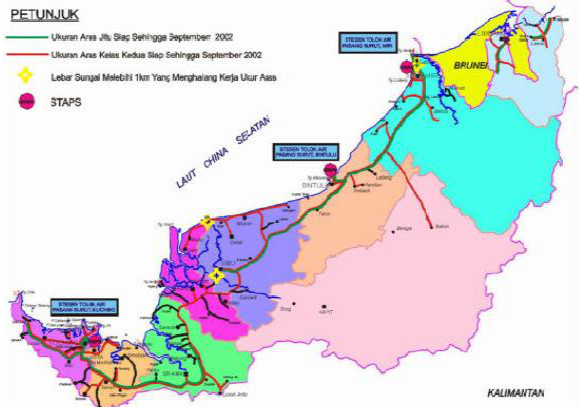
Figure 2. Precise levelling routes of Sarawak as at 2002 (Source - Muhamad Asrul 2006)